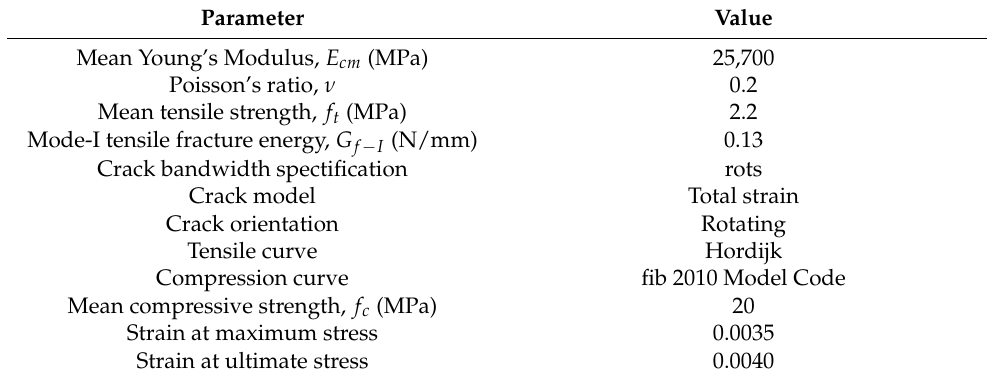
Table 3. Cement paste properties.